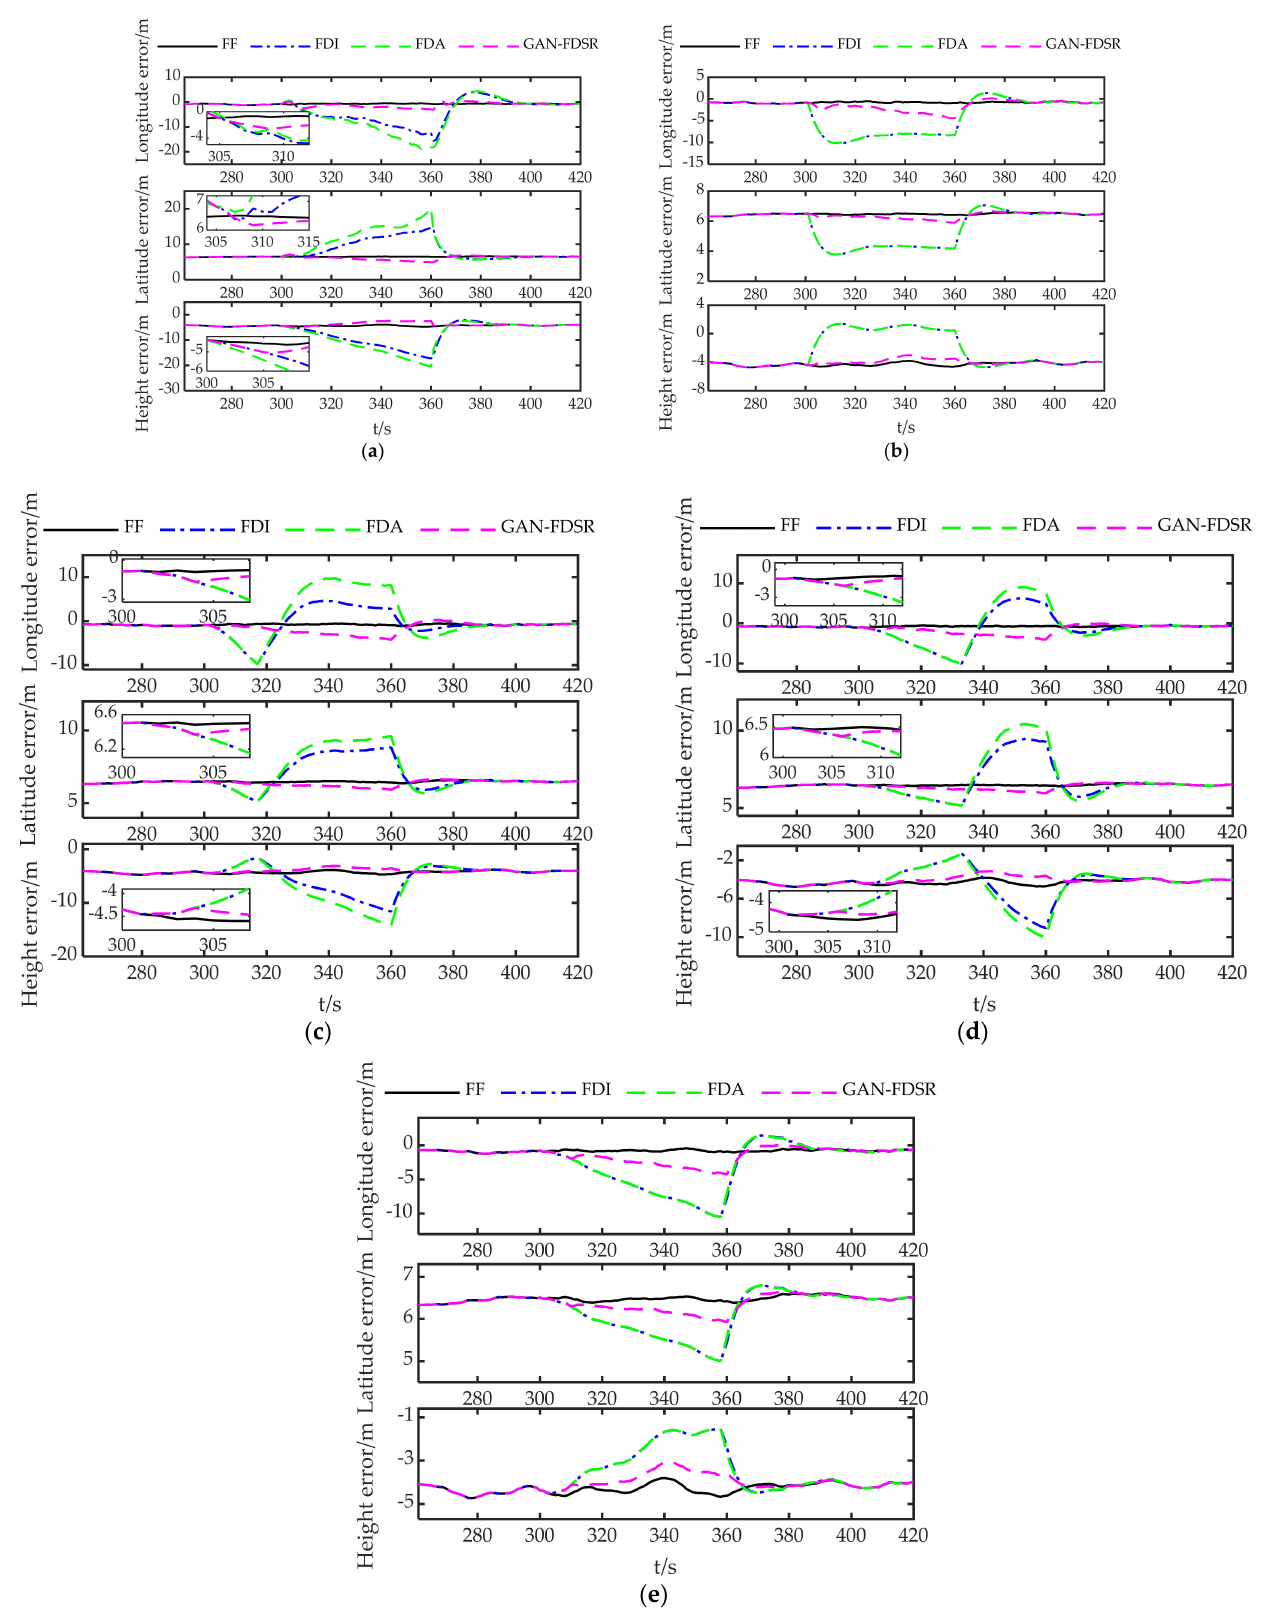
Figure 11. Positioning errors for three methods: ( a – e ) show the positioning errors under Type 1, Type 2, Type 3, Type 4 and Type 5 faults,